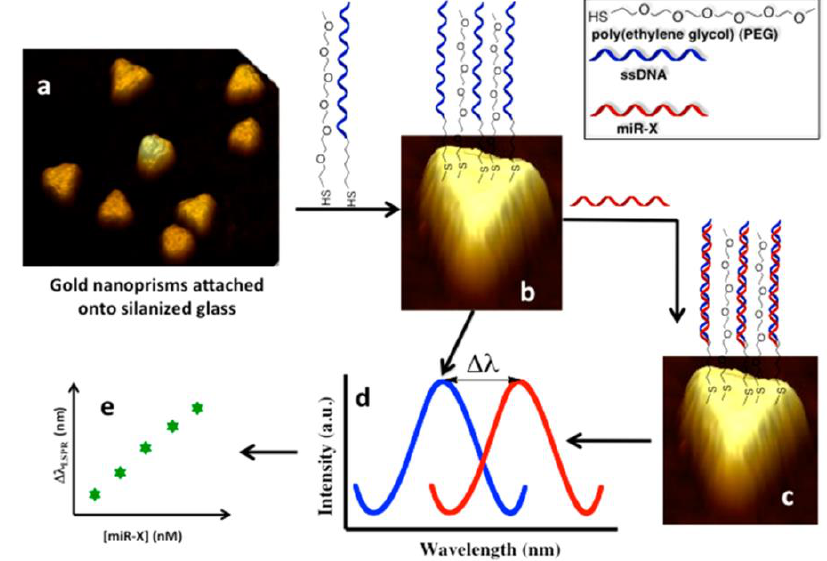
Figure 12. Plasmonic biosensors based on nanoprisms: ( a ) Chemically synthesized gold nanoprisms covalently attached onto glass coverslip via 3-mercaptopropyltriethoxysilane-functionalized. ( b ) Surface modification of gold nanoprisms equimolar mixture of SH-C6-ssDNA-X and PEG6-SH in PBS buffer (pH 7.4). ( c ) Incubation of sensor in miR-X solution and formation of DNA duplex. ( d ) Extinction spectrum of the surface modification with SH-C6-ssDNA-X and PEG6-SH (blue curve) and after incubation with miR-X (red curve). ( e ) Plot of Δλ LSPR versus log of miR-X concentrations. Reproduced with permission from [62]. Copyright American Chemical Society, 2014.